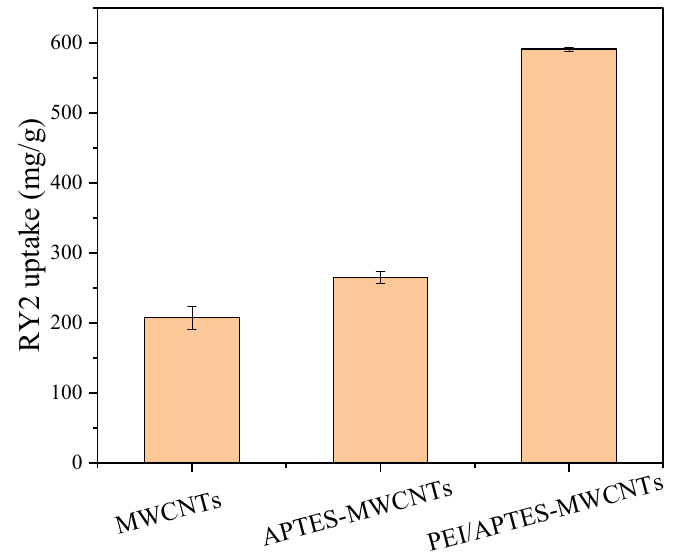
Figure 1. RY2 uptake on MWCNTs, APTES-MWCNTs, and PEI/APTES-MWCNTs. (C i = 200 mg/L, sorbent amount = 10 mg, pH = 2).